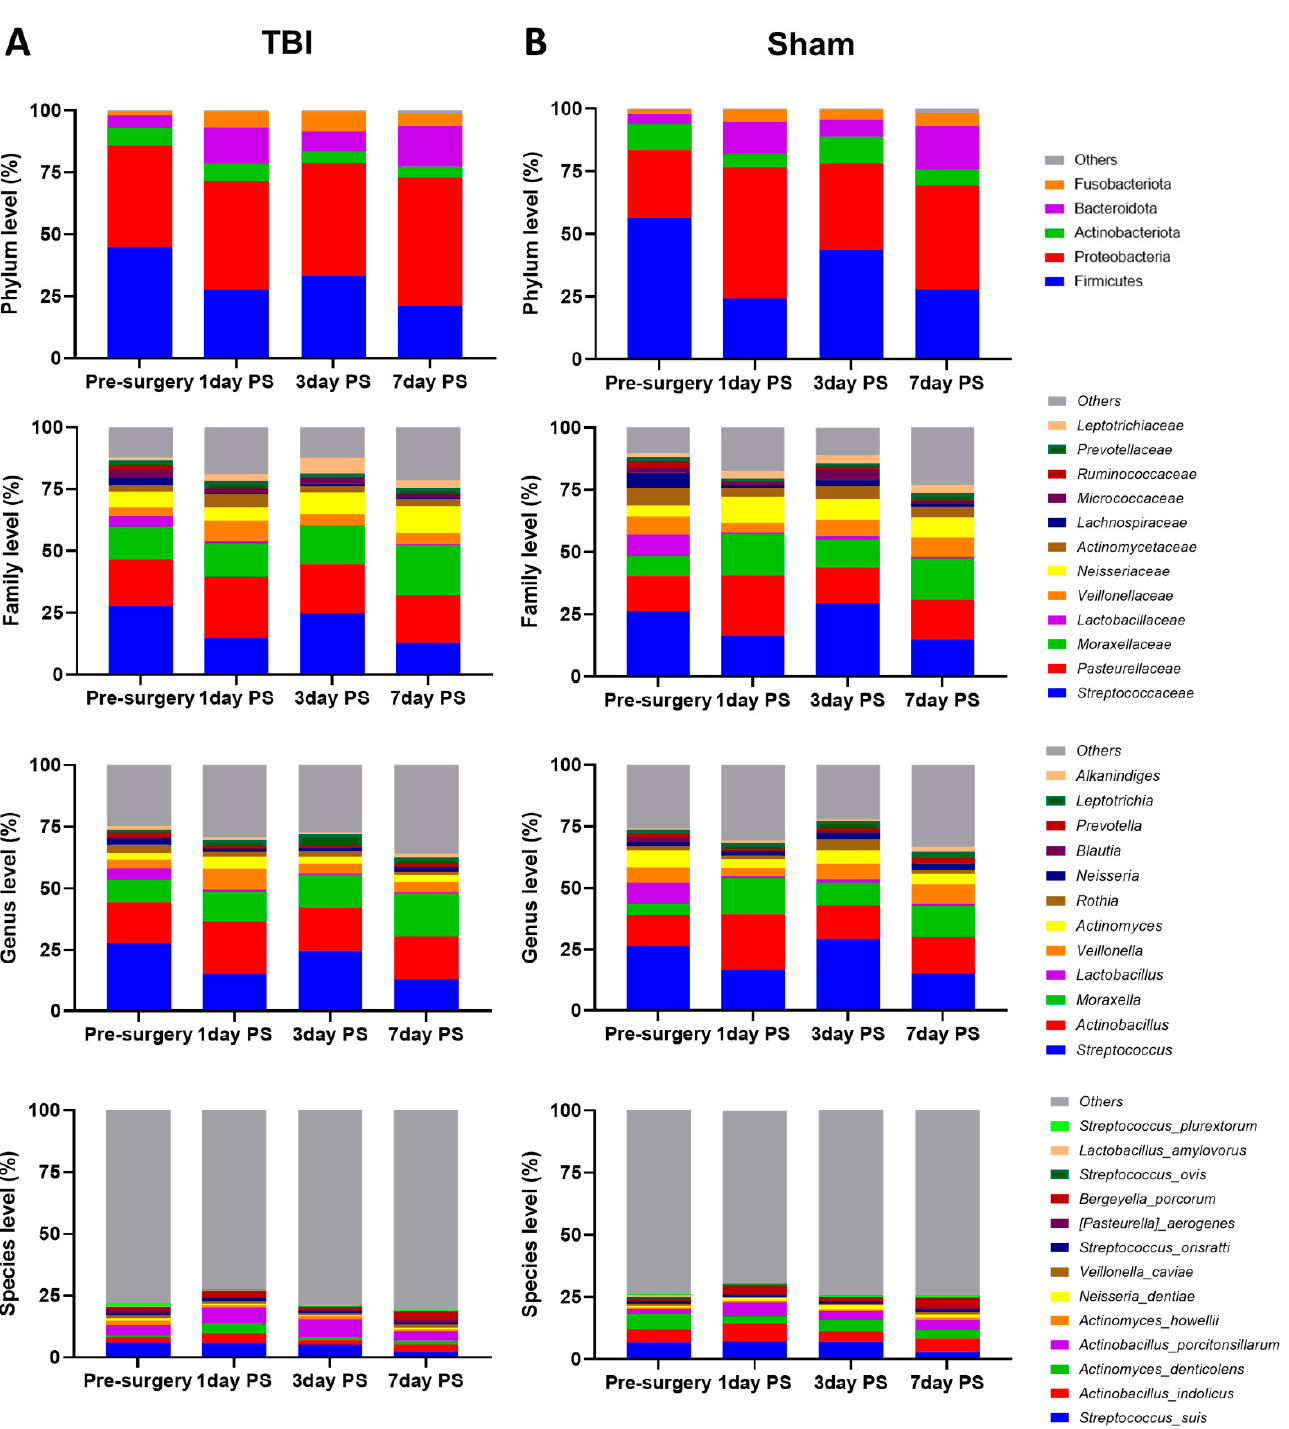
Figure 3. TBI did not significantly change the taxonomic composition of the oral microbiome between TBI and sham piglets. The oral microbial composition was analyzed at the phylum (>1%), family (>1%), genus (>1%), and species (>0.5%) levels pre-surgery and 1, 3, and 7 days post-surgery in ( A ) TBI ( n = 6) and ( B ) sham ( n = 6) groups. There were no significant compositional differences between TBI and sham groups up to 7 days post-surgery. TBI, traumatic brain injury; PS, post-surgery .